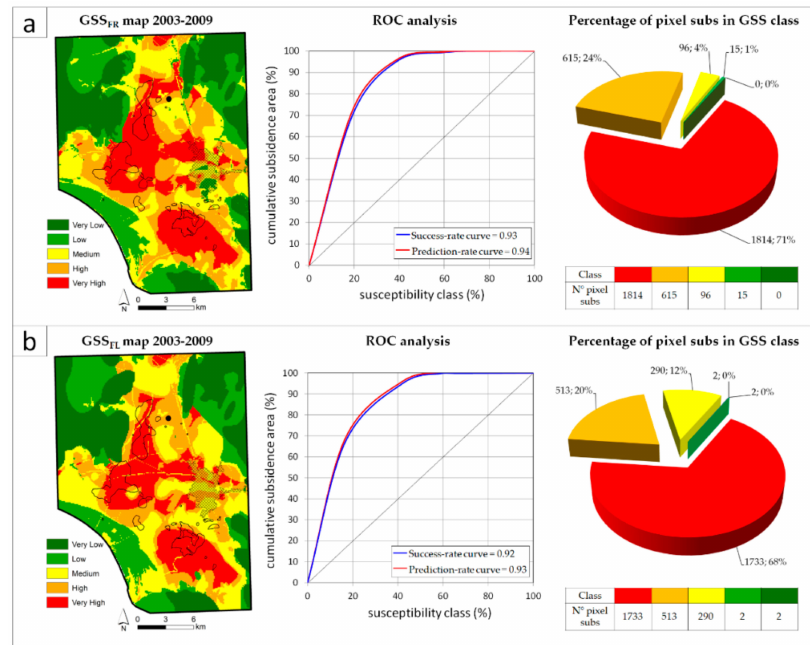
Figure 6. GSS maps output and validation results: ( a ) GSS FR map 2003–2009. The location of Bottegone sinkhole in 1999, the Grosseto urban fabric and the 2003–2009 subsidence inventory are overlapped on the maps; ROC analysis of the success-rate and the prediction-rate curves; pie chart of percentages of pixel in subsidence falling into each susceptibility classes; ( b ) GSS FL map 2003–2009; ROC analysis of success-rate and prediction-rate curves; pie chart of percentages of pixels in subsidence (‘pixel subs’) falling into each susceptibility